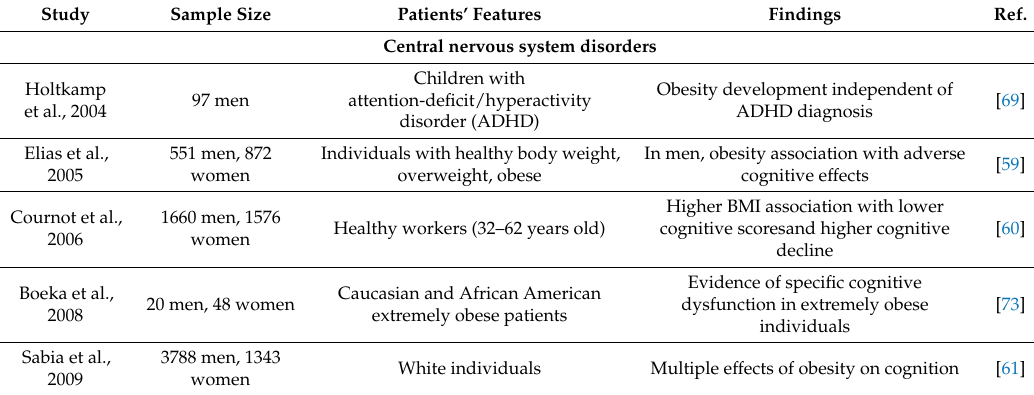
Table 1. Clinical studies showing an association between obesity and central nervous or peripheral neurological